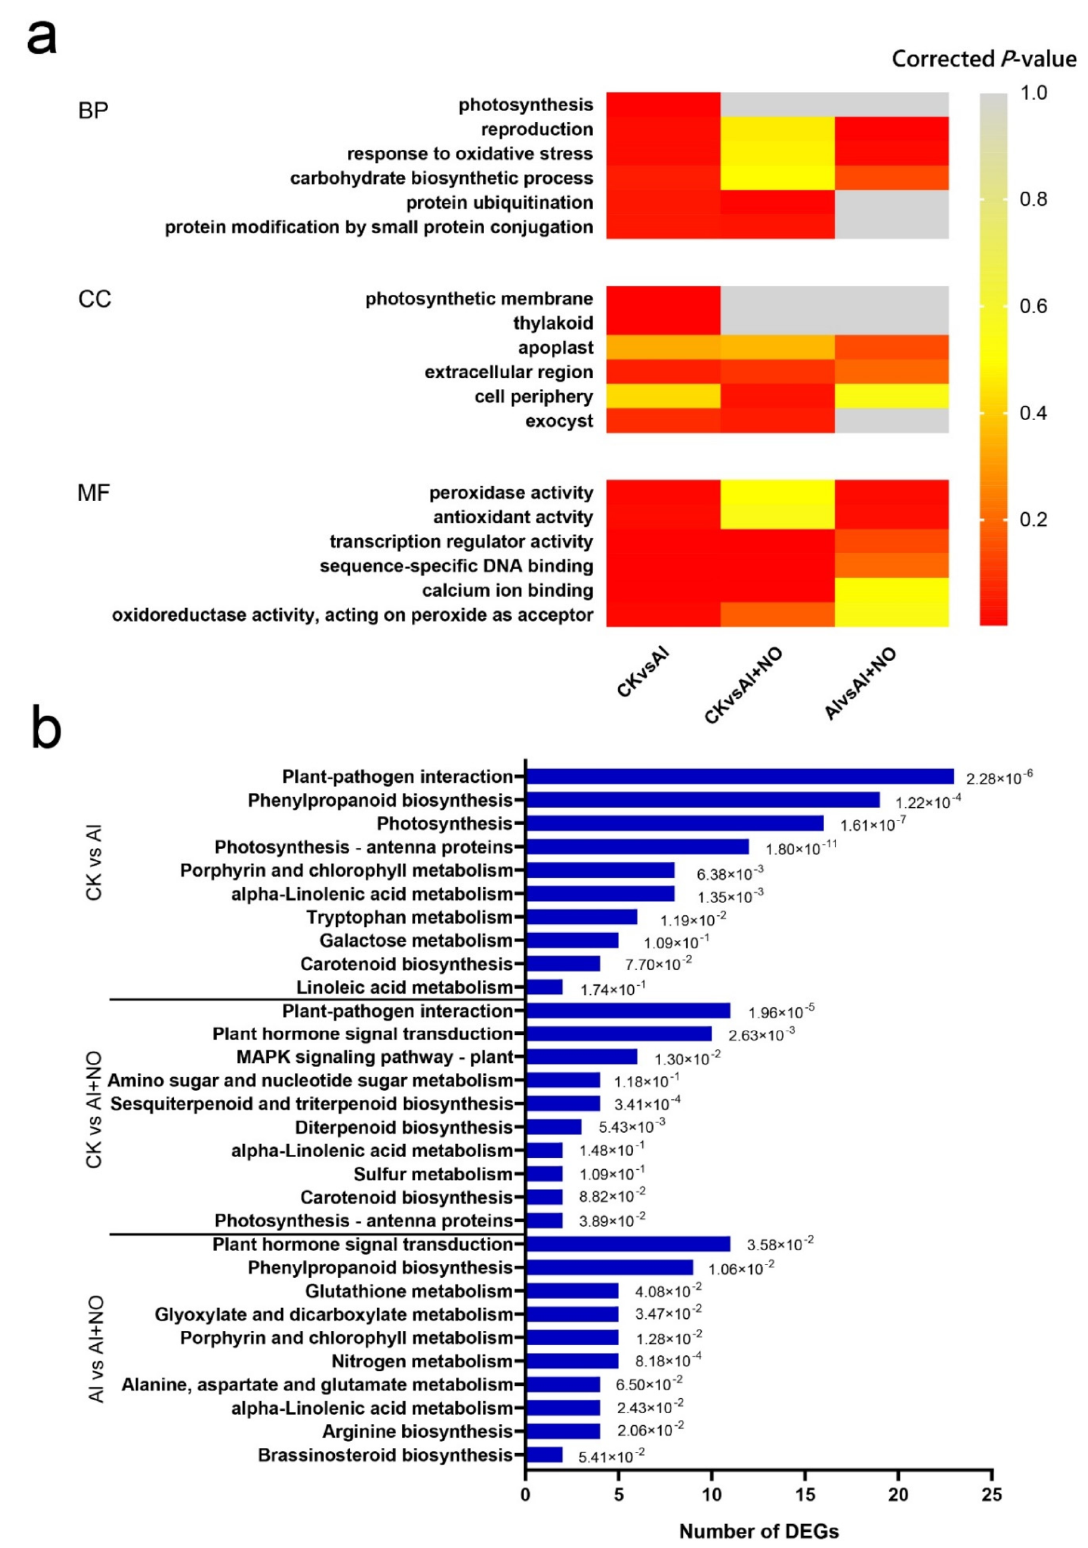
Figure 7. Annotation of DEGs. ( a ) GO enrichment analysis of DEGs. BP, biological process; CC, cellular component; MF, molecular function. Corrected p -value < 0.05 denotes significantly enriched terms; the smaller the p -value, the closer the color is to red and the more significant the enrichment. ( b ) KEGG enrichment analysis of DEGs. The top 10 enriched terms with highly significant p -values ( ≤ 0.05) in each comparison are